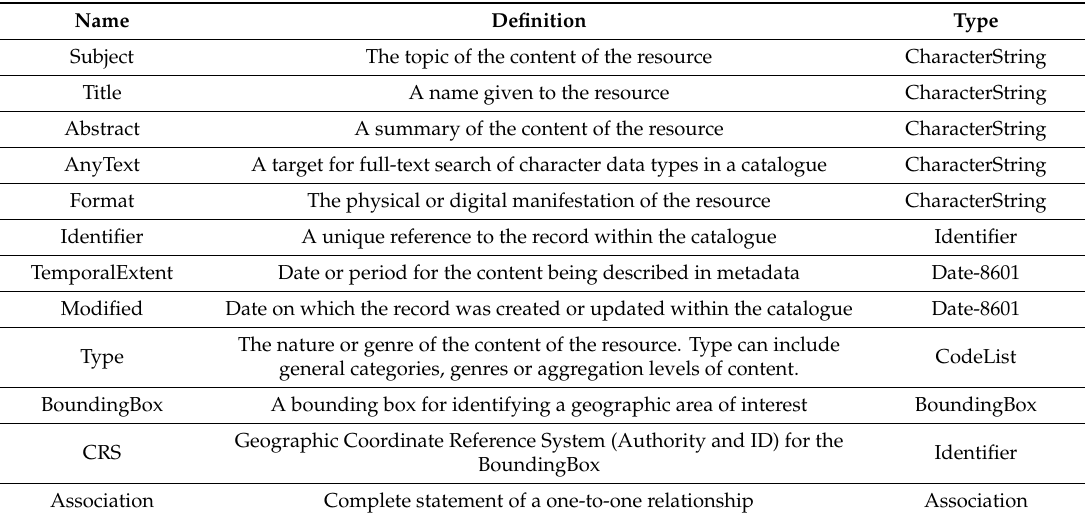
Table 12. OGC CSW Core queryable.